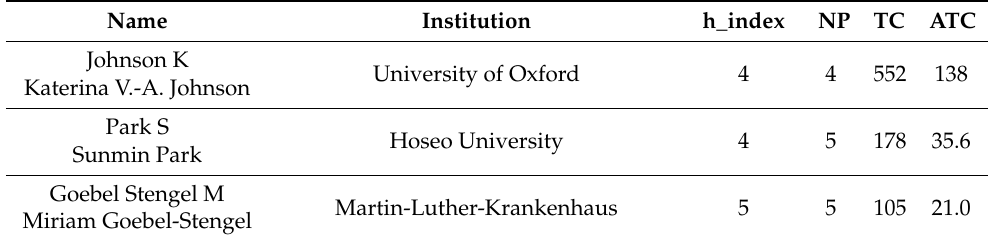
Table 3. Top 10 authors contributed to microbiome–gut–brain axis and dementia related